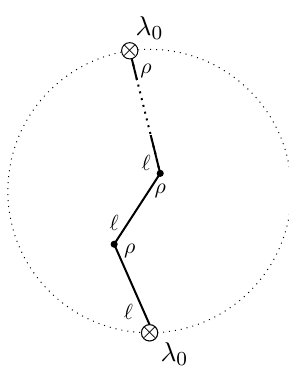
Figure 1 . The subdiagram chain that starts and ends with two di(cid:11)erent insertions of vertices that contain a (cid:21) 0 (cid:12)eld. The dotted circle denotes the Feynman diagram